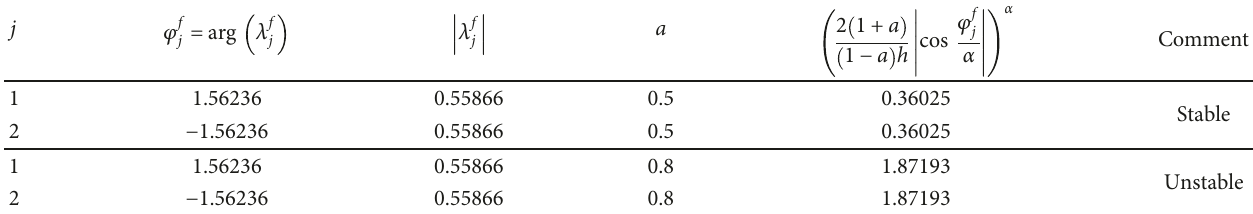
Table 2: Stability properties of discretized fractional-order system; Example 2.